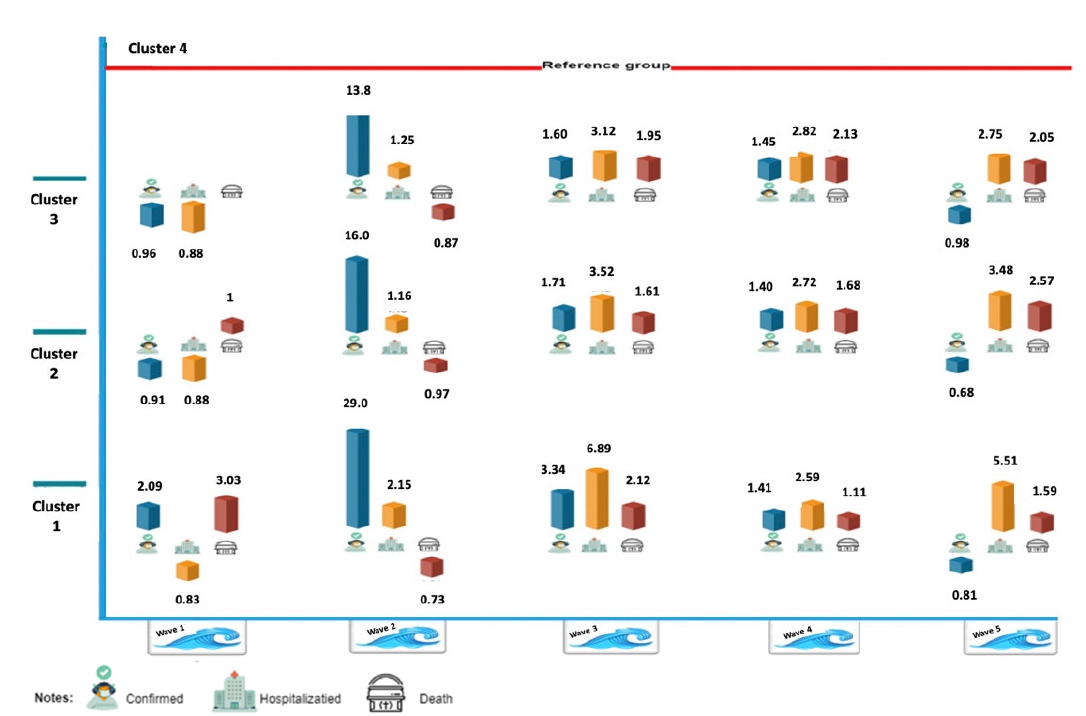
Table 2. The 95% Confidence Intervals (CI) (left) for the Relative Risk of each cluster (1–3) and clus- ter 4 (reference) for each wave for confirmed, hospitalized, and death cases and p -values (right).